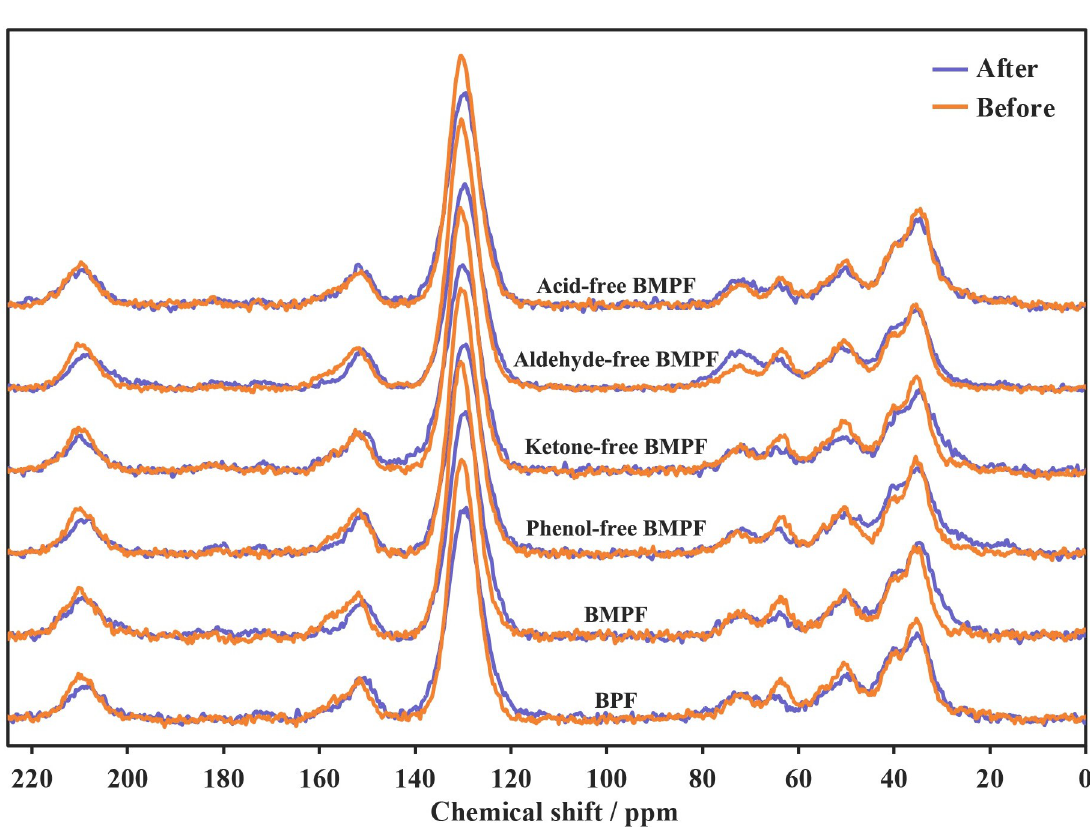
Fig 2. 13 C NMR images of BMPFs before and after aging for 960 h. https://doi.org/10.1371/journal.pone.0271478.g002 After aging for 960 h, the intensity of C = O from carboxylic acids and esters (186– 168 ppm) increased, which meant that some oxidative aging reaction happened during the aging of BMPFs. The intensity of C = O from aldehydes (220–200 ppm) decreased, suggesting that some aldehyde groups were converted to carboxyl or ester groups. The reduction of the